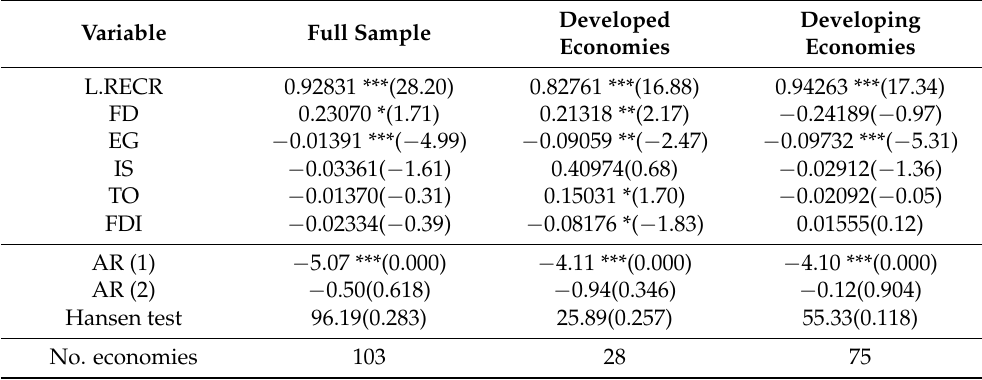
Table 13. Regression results with RECR. Variable Full